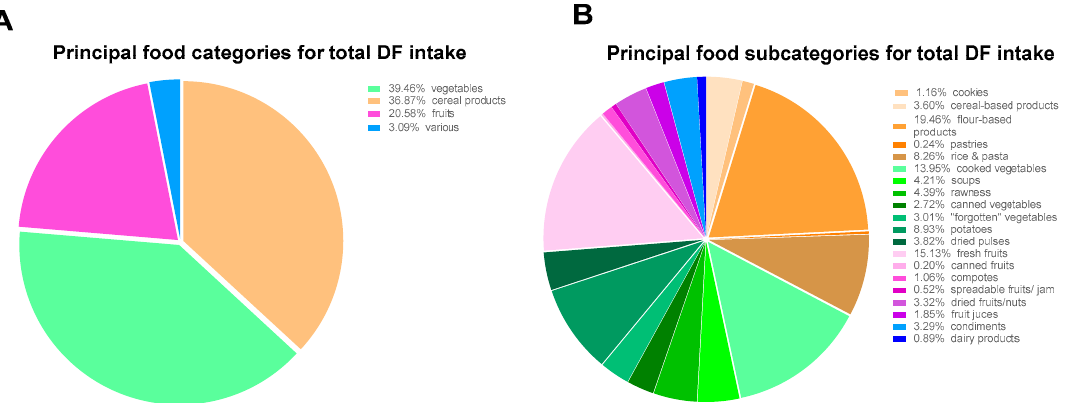
Figure 2. Contribution of food sources divided into categories ( A ) and subcategories ( B ) to the daily total dietary fiber intake. Data are determined from the FiberTAG Food Frequency Questionnaire submitted to healthy volunteers using the FiberTAG repertoire.